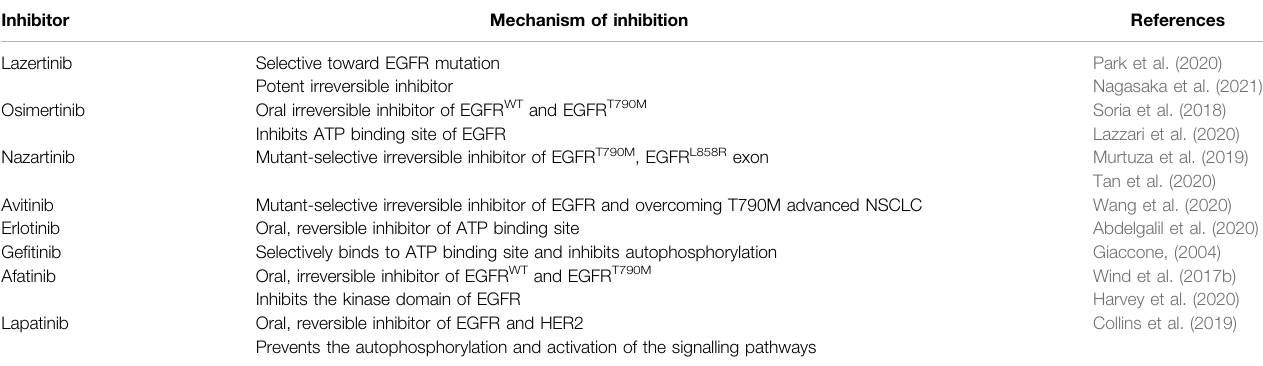
TABLE 1 | Details of various EGFR inhibitors and their mechanisms.